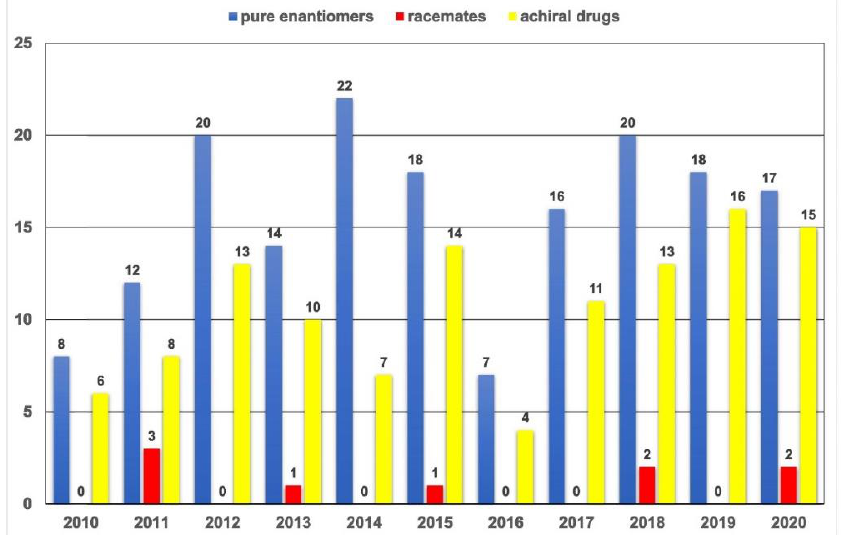
Figure 1. Comparison of the annual number of medications authorized by the FDA between 2010 and 2020 (pure enantiomers vs. racemates vs. achiral drugs).